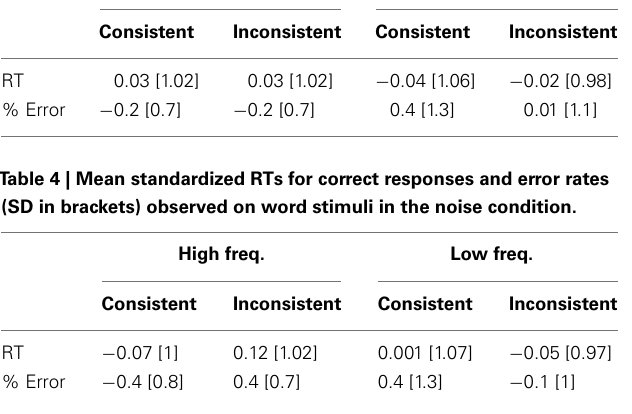
Table 3 | Mean standardized RTs for correct responses and error rates (SD in brackets) observed on word stimuli in the silent condition. High freq.